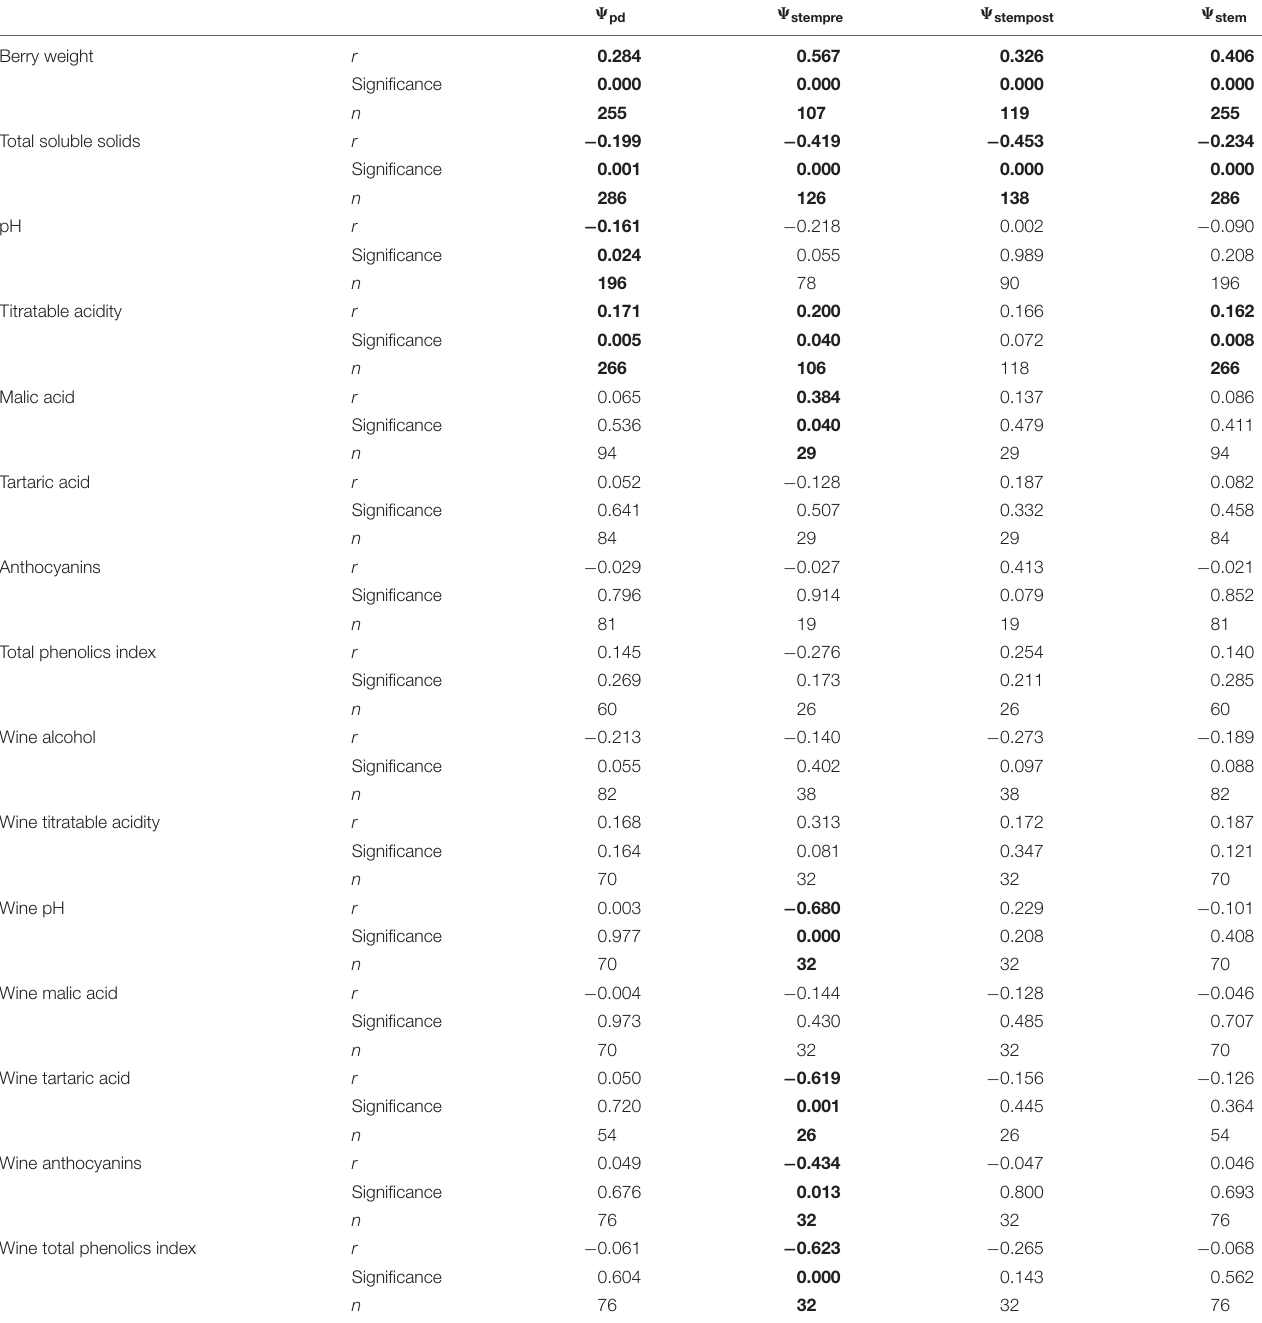
TABLE 2 | Pearson’s correlation coefficients ( r ) among different modalities of vine water status assessment and berry size and compositional traits for red